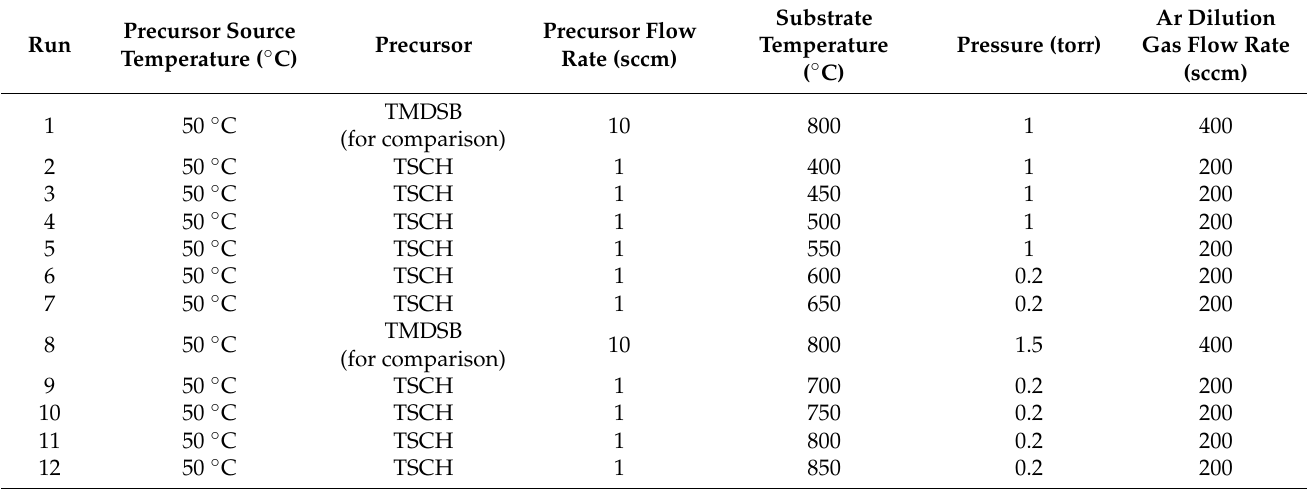
Table 2. Design of experiments (DOE) processing parameters for TCVD